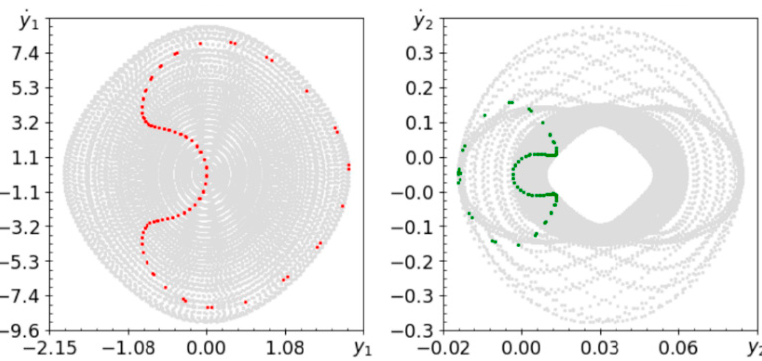
Figure 7. Phase planes (gray lines) and Poincar é maps (red and green dots) for A = 0.1, ω = 7.64. Table 4. Spectra of Lyapunov exponents for the first mutation of rigid